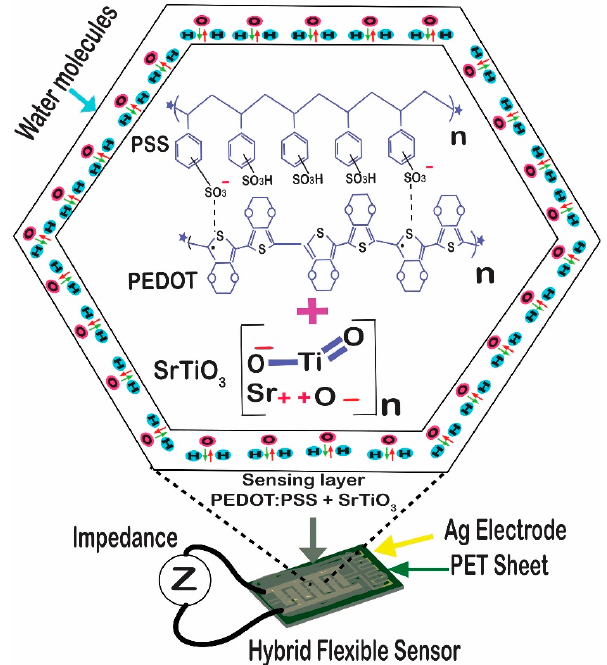
Figure 4. Working principle of the humidity sensor. For the temperature sensor, it was quite simple; an increase in temperature caused an increase in the impedance.